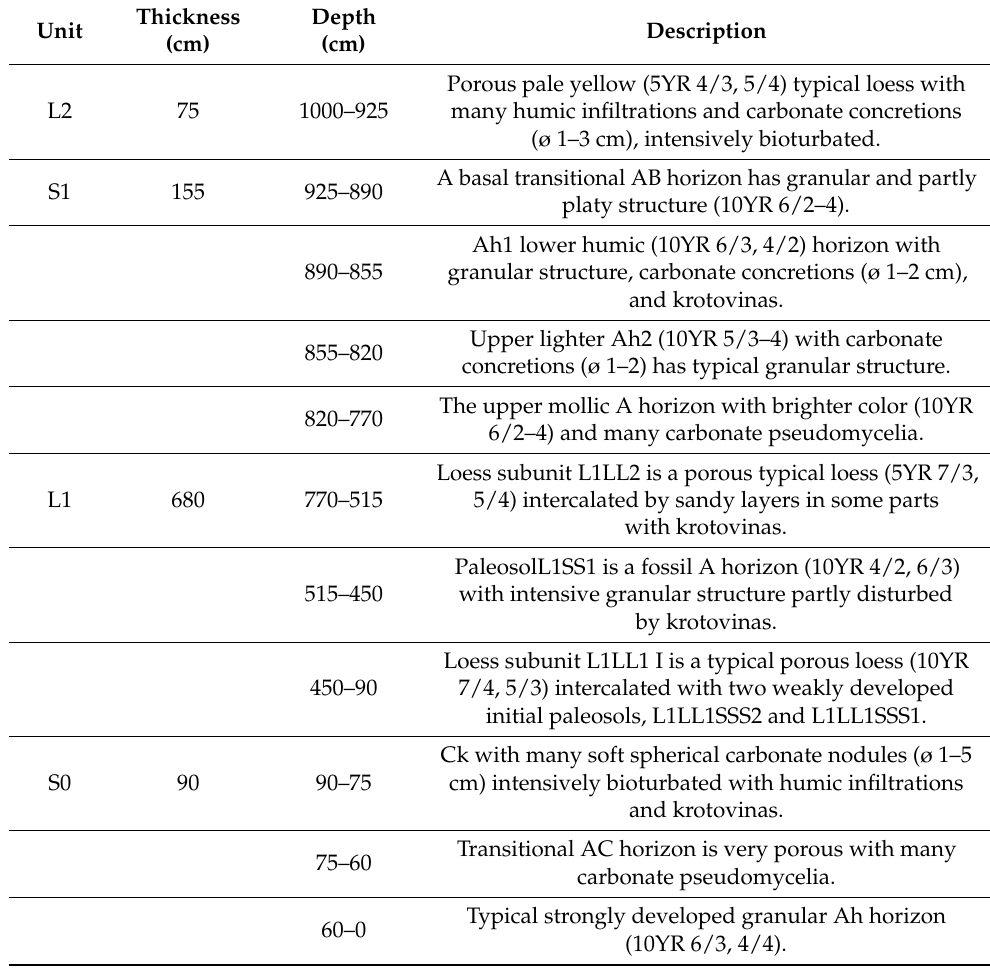
Table 1. Detailed morphological description of the loess–paleosol sequence at the Novo Orahovo